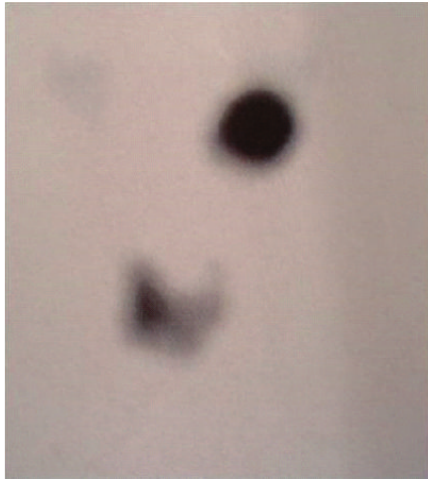
Figure 3: Radioactivity uptake in the normal localization of the thyroid gland and in the submandibular localization on thyroid scintigraphy with Tc-99m